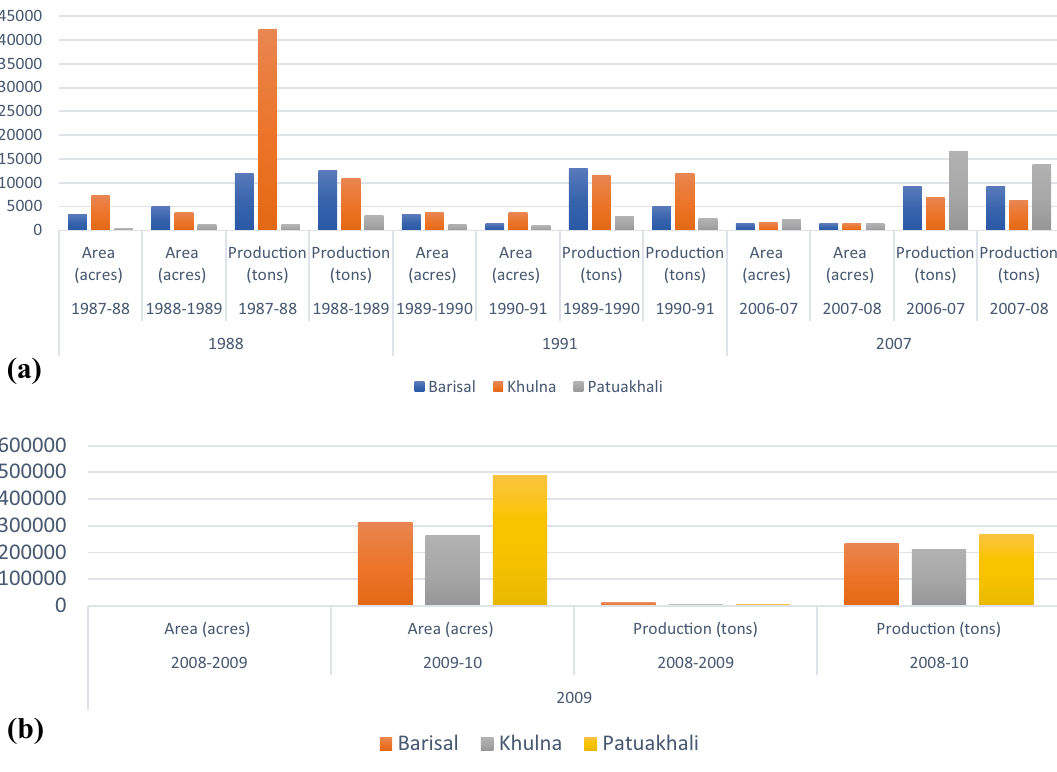
Fig. 7 a Production and area variance of potato for years 1988, 1991, 2007; b production and area variance of potato for years 2009. Source: “45 years Agriculture Statistics of Major